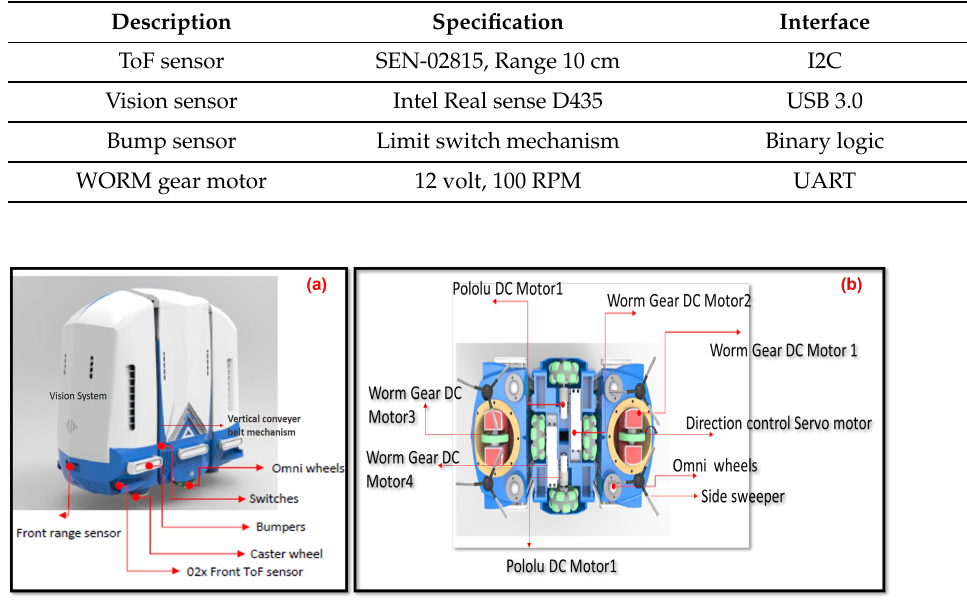
Figure 4. ( a ) Sensor assembly. ( b ) Locomotion DC motor